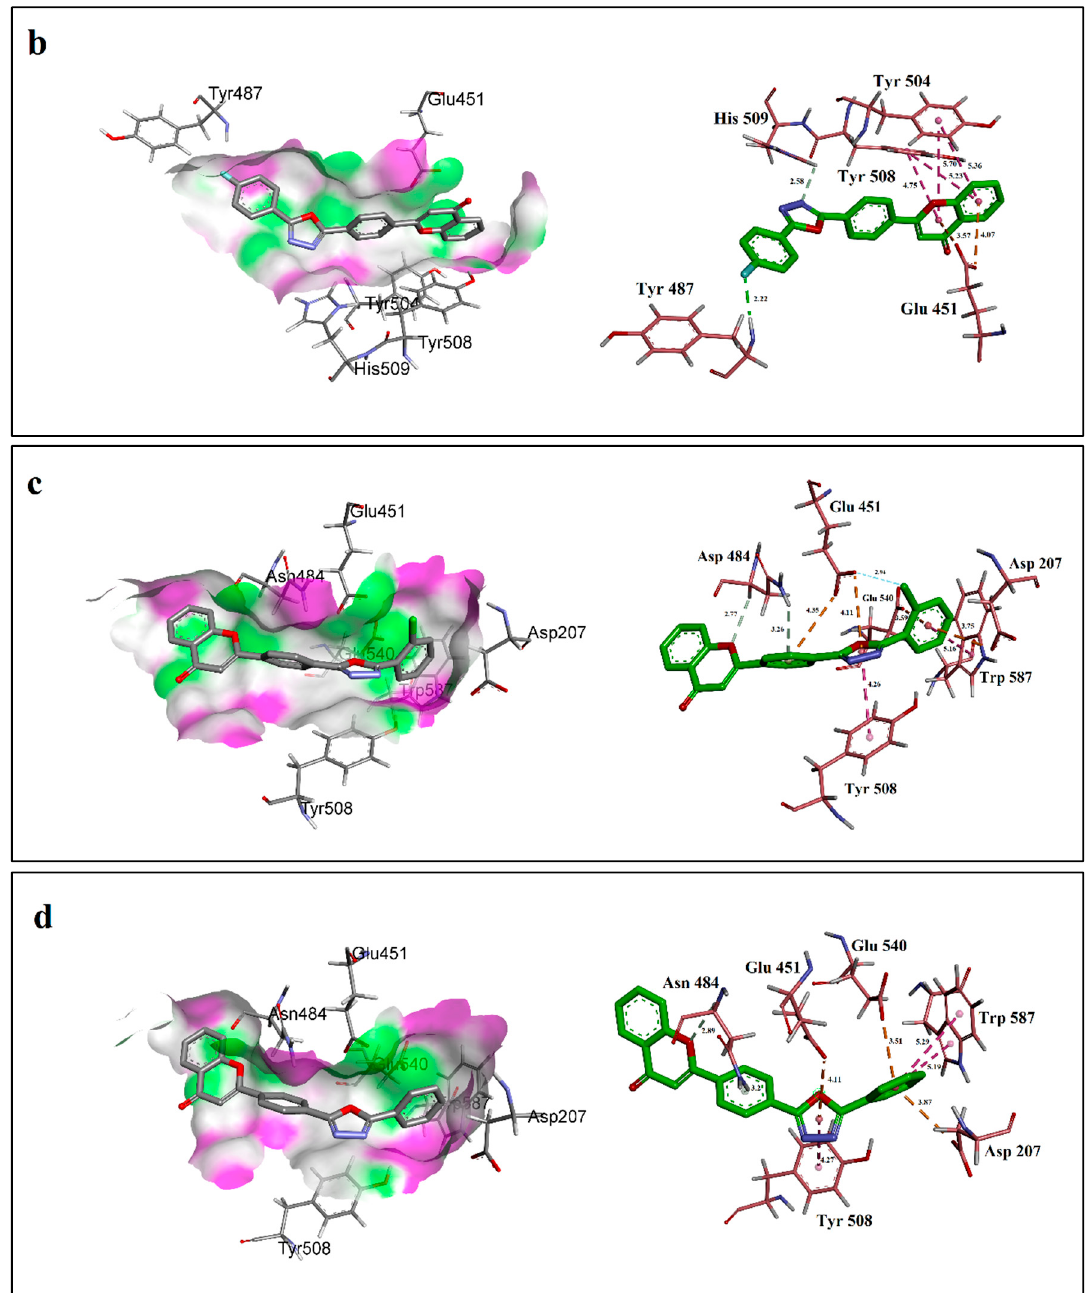
Figure 3. Ligand–protein interactions of compound ( a ) 6, ( b ) 4, ( c ) 3 and ( d ) 19 with the active site of β -glucuronidase (1BHG) created by using Discovery Studio 17.2. The left side displays 3D maps of the hydrogen bonds of the compounds in the binding site. The right side shows the 2D interaction patterns. Dashed lines show the interactions among the ligand and the amino acids of the protein. Distances are in